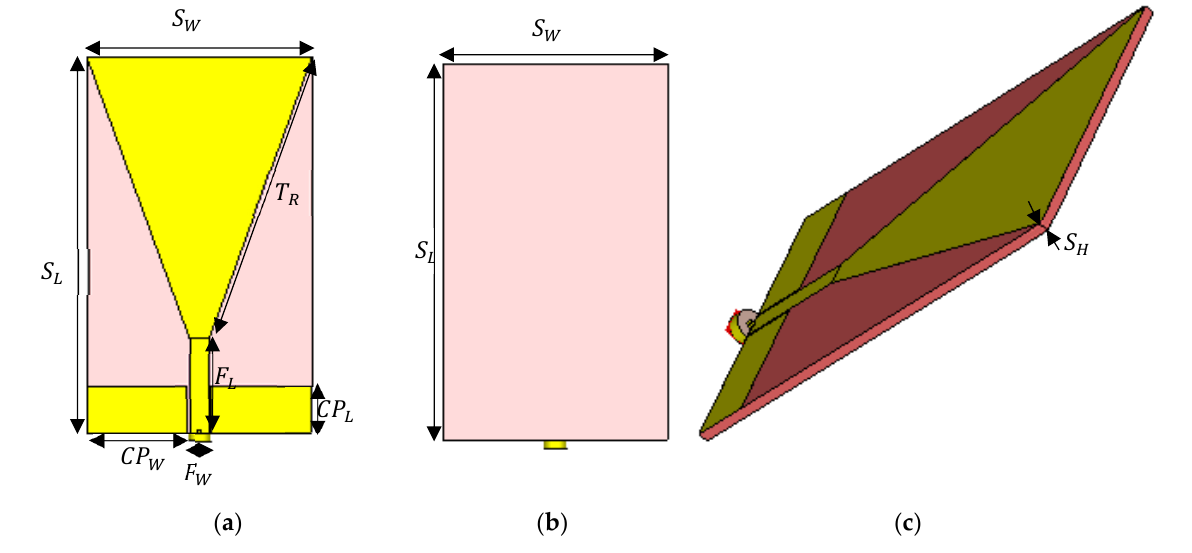
Figure 1. Base antenna ( a ) front ( b ) back ( c ) perspective. Table 1. Dimensions of base antenna parameters.